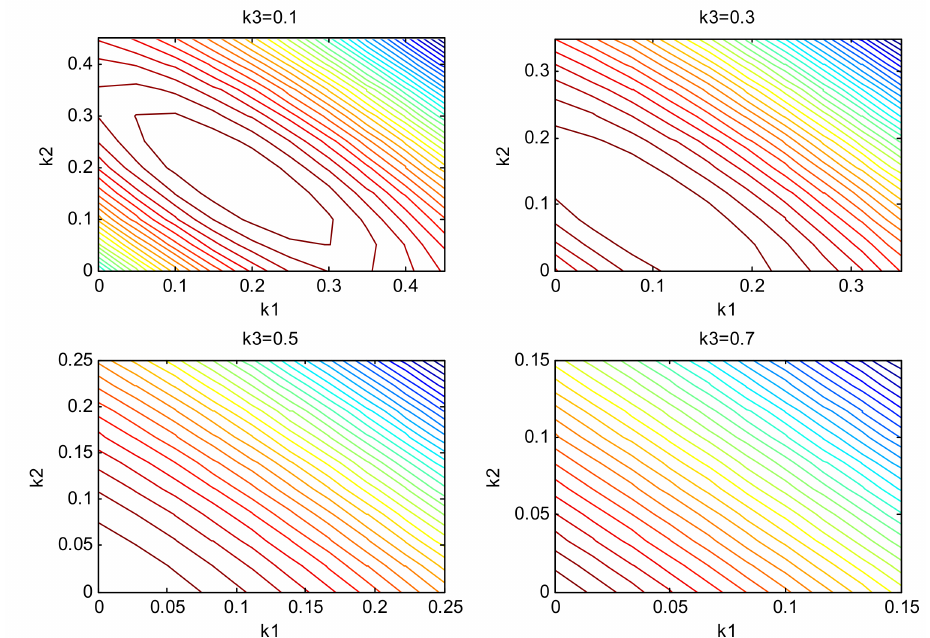
Figure 10. E ff ect of k 1 and k 2 on the system ISE value for di ff erent k 3